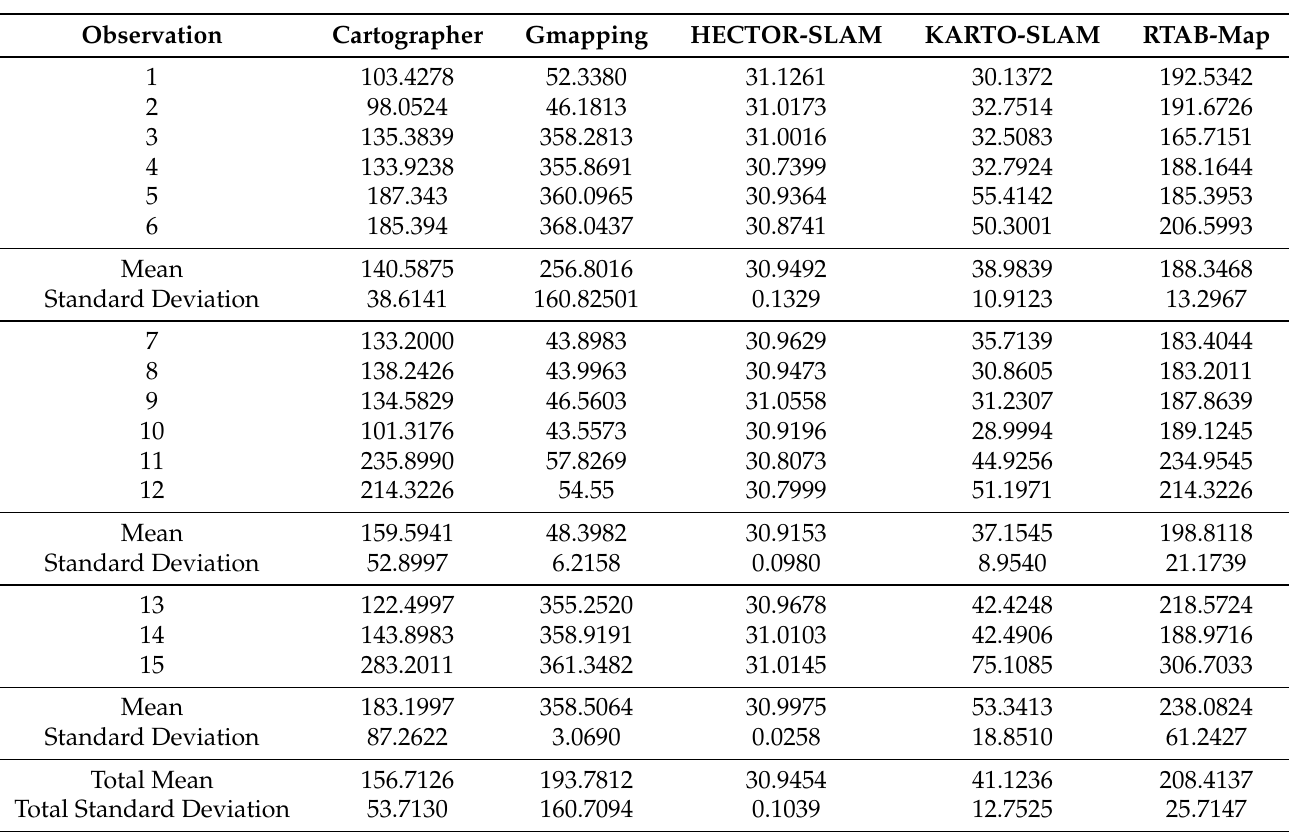
Table 14. Observation means for memory usage.